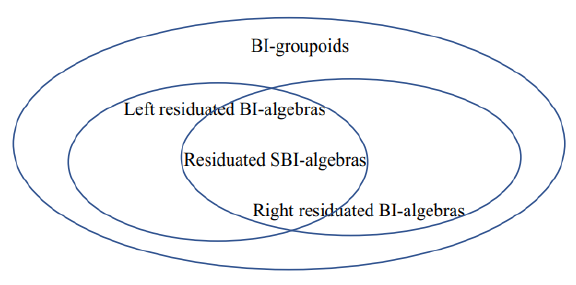
Figure 2. The relationships among some algebraic